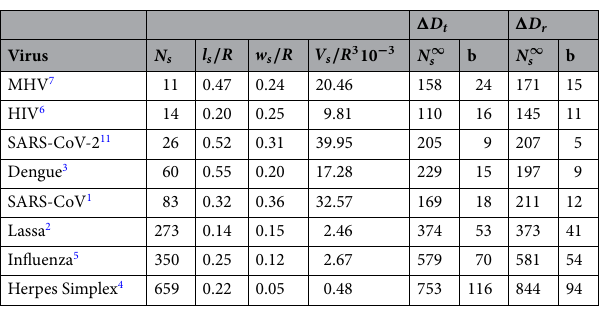
3 for different virions, along